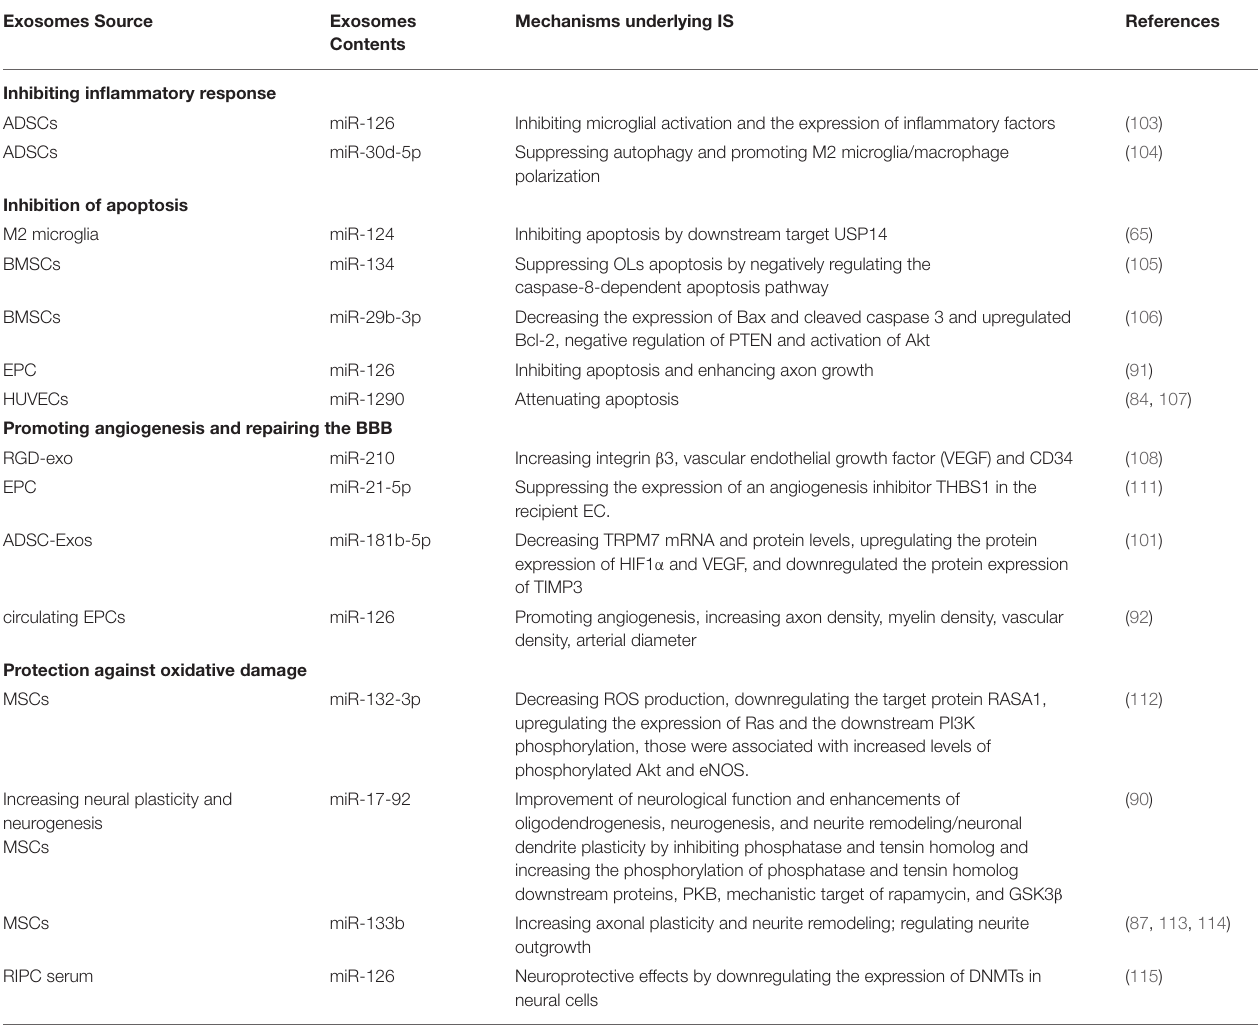
TABLE 3 | Mechanism underlying the actions of exosomal miRNAs from different cells on ischemic